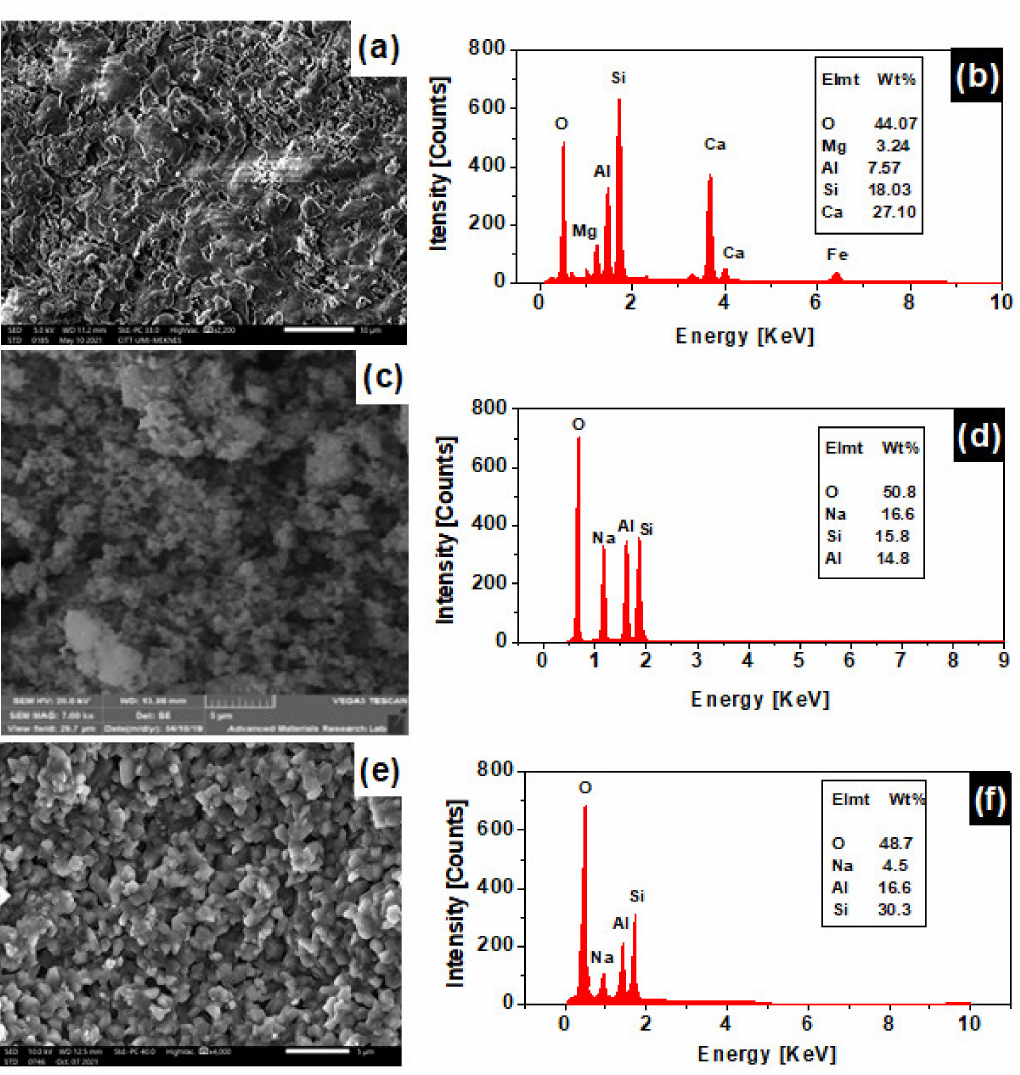
Figure 6. SEM micrographs and EDX analysis of the clay support ( a , b ), the SOM composite clay/zeolite membranes ( c , d ), and FAM composite clay/zeolite membranes ( e , f ). 3.6. The Point of Zero Charge of the Clay Supports, SOM and FAM Membranes The surface charge density, σ o in µ C · cm − 2 , is calculated by computing the curve of the blank titration, carried out in the absence of the solid, with that obtained in the